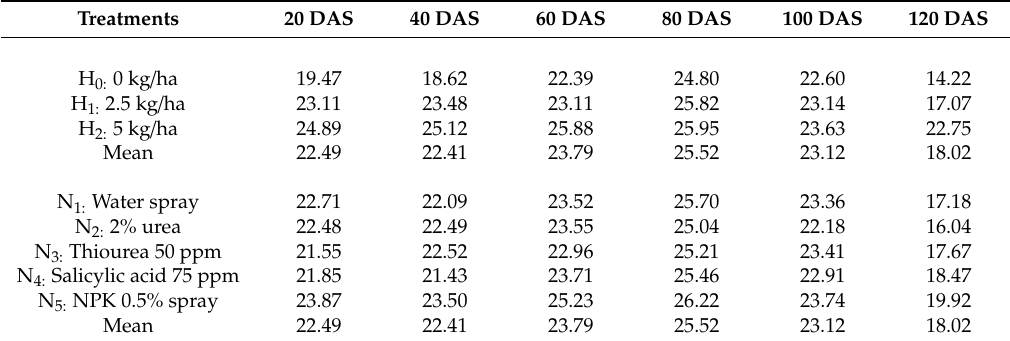
Table 4. Moisture % in the soil during crop growth stages (average data of three years). Treatments 20 DAS 40 DAS 60 DAS 80 DAS 100 DAS